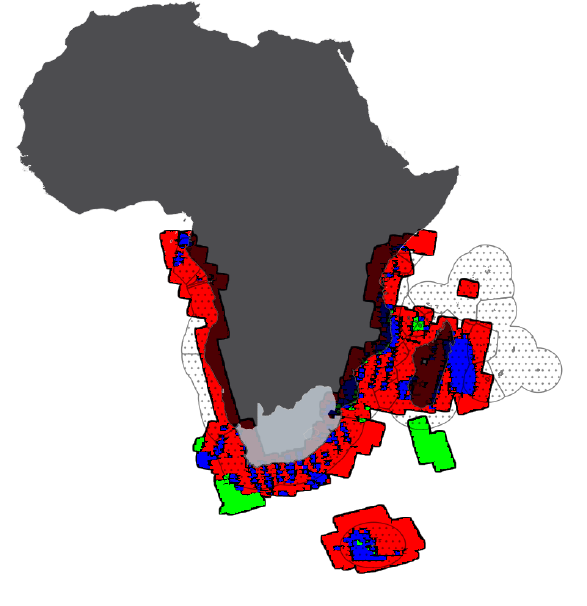
Figure 8. SAR Image Coverage in 2021 (Only Sentinel-1). Where Green, Blue and Red represent High, Medium, Low coverage respectively.